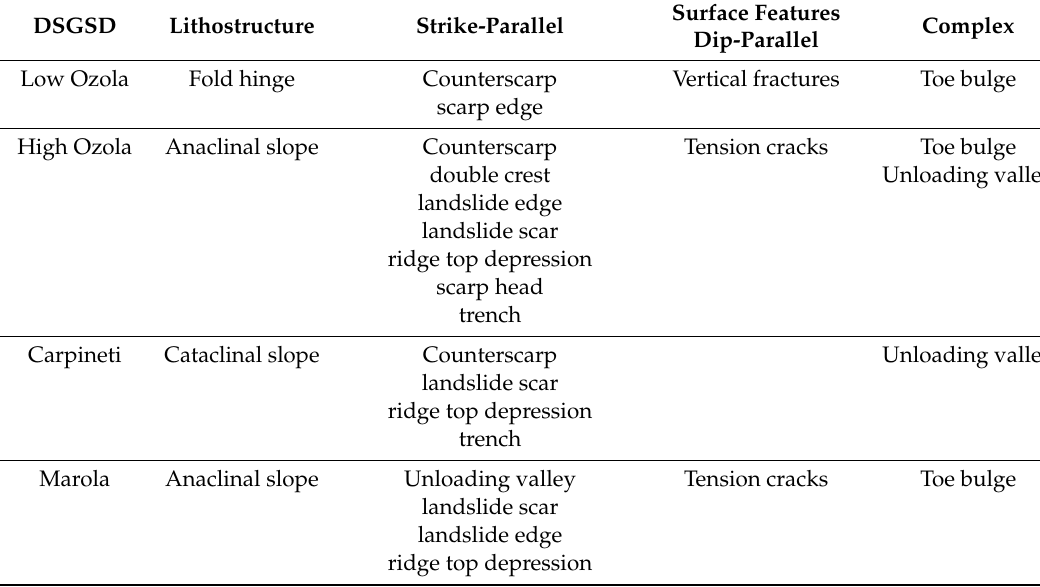
Table 1. Surface geomorphological features identified on each investigated